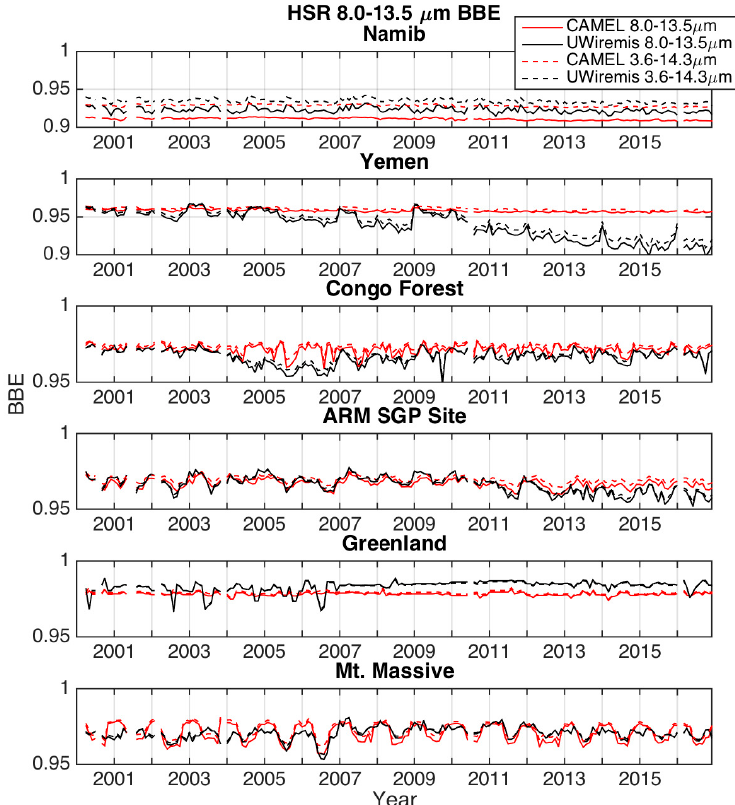
Figure 3. Time series of monthly average 0.5° × 0.5° CAMEL (red) and UWIREMIS (black) 8.0–13.5 µm (solid) and 3.6–14.3 µm (dashed) BBE for five sites (see Figure 1 for single month of corresponding emissivity spectra).